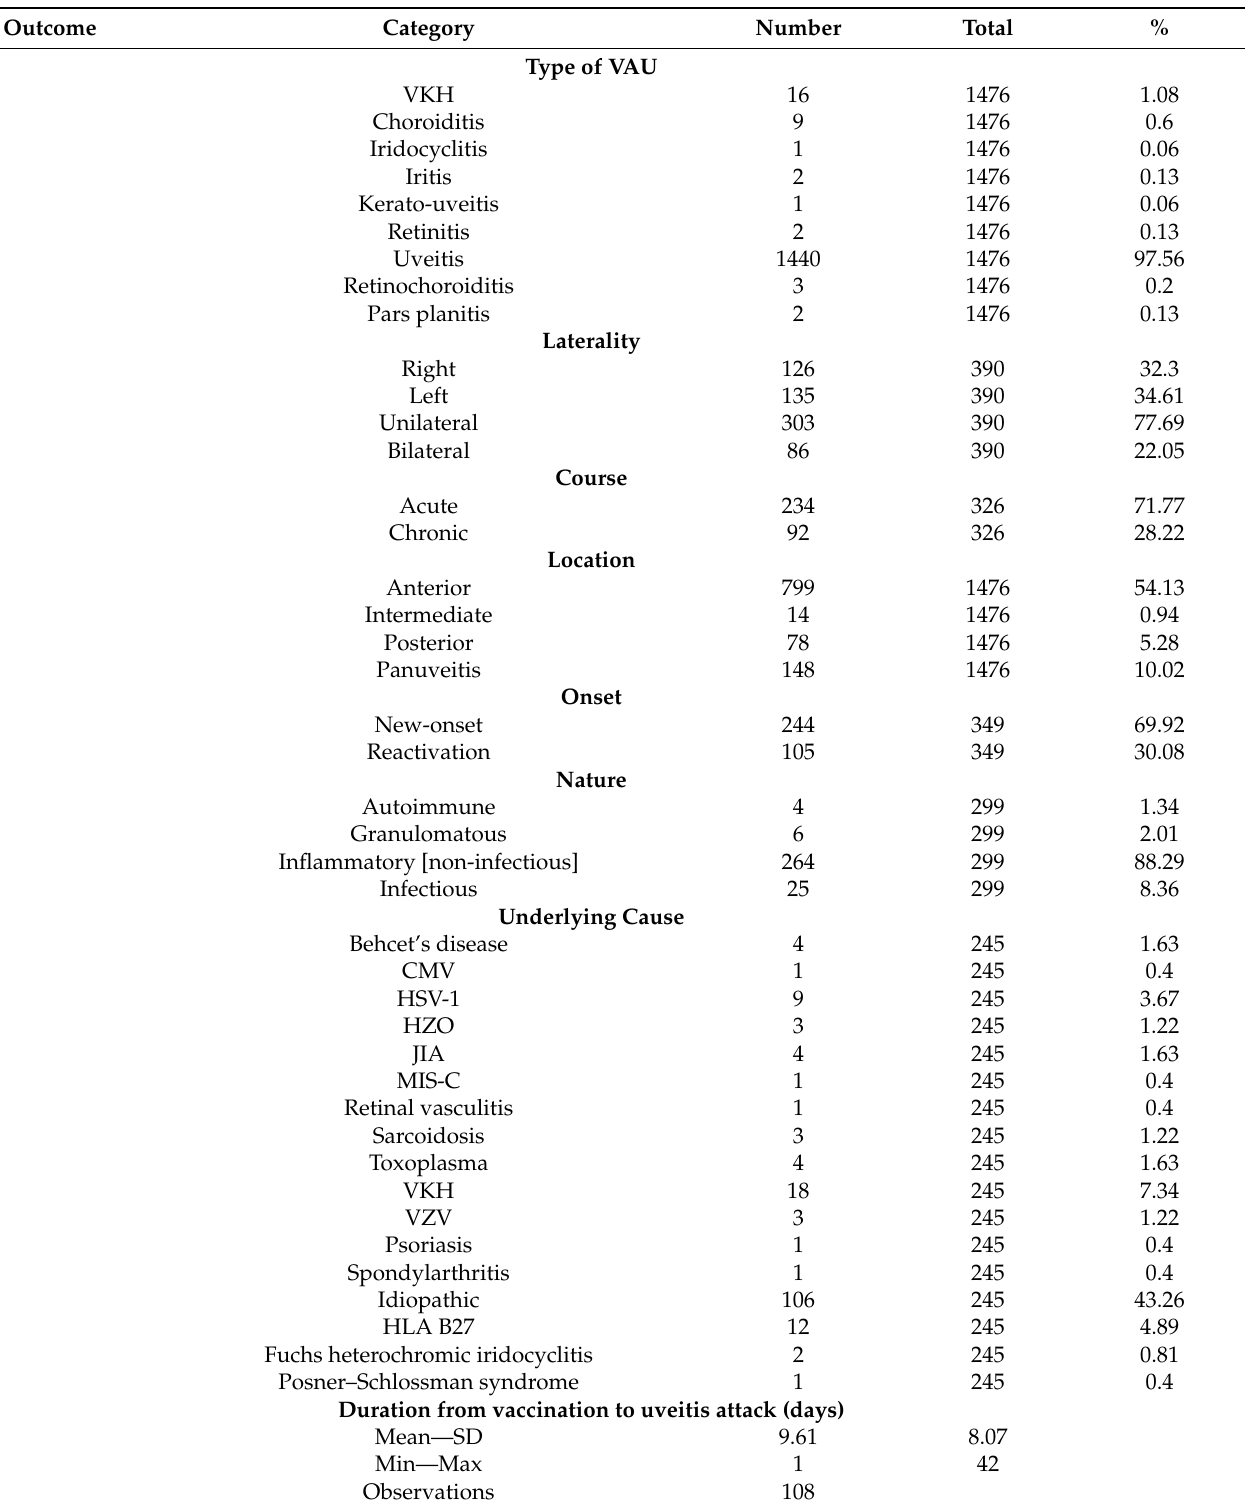
Table 5. The type, laterality, course, location, onset, nature, and underlying cause of vaccine- associated